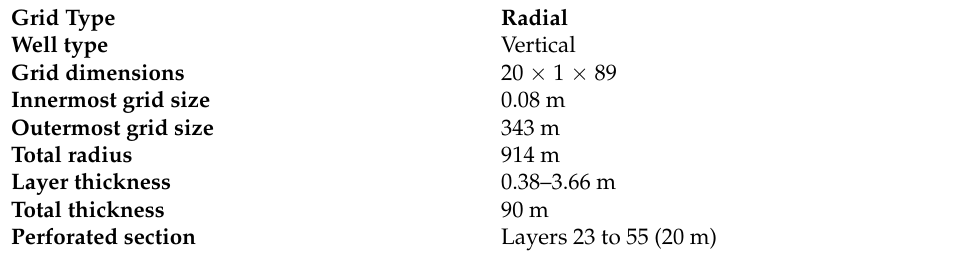
Table 1. Single-well model